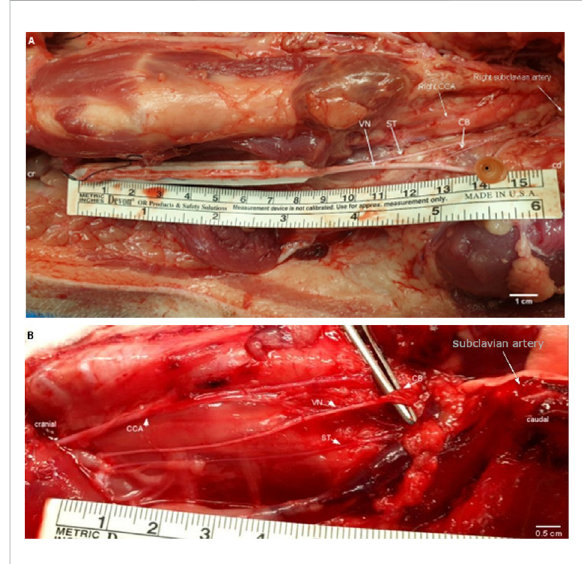
FIGURE 2 (A) .Surgicalwindowoftherightcervicalandcardiacregionin a pig. White arrows point at the VN, the ST, and the superior CB. ThepositionsoftheCCAandrightsubclavianarteryarelabeledfor anatomical orientation. The inferior cardiac branch was not usedin thisstudy andislocated caudal to thesubclavianartery. Cr, cranial; cd, caudal; CCA, common carotid artery; VN, cervical vagus nerve; ST, sympathetic trunk; CB, superior cardiac branch. (B) . Surgical window of the right cervical and cardiac region in a rabbit. The cervical VN gives one superior CB to the heart. White arrows point at the VN; the ST; and the superior CB. Single white arrow pointing at position of the subclavian artery (behind rib cage). The inferior cardiac branch was not used in this study and is located below the subclavian artery. VN, vagus nerve; ST, sympathetic trunk; CB, superior cardiac branch; CCA, common carotid